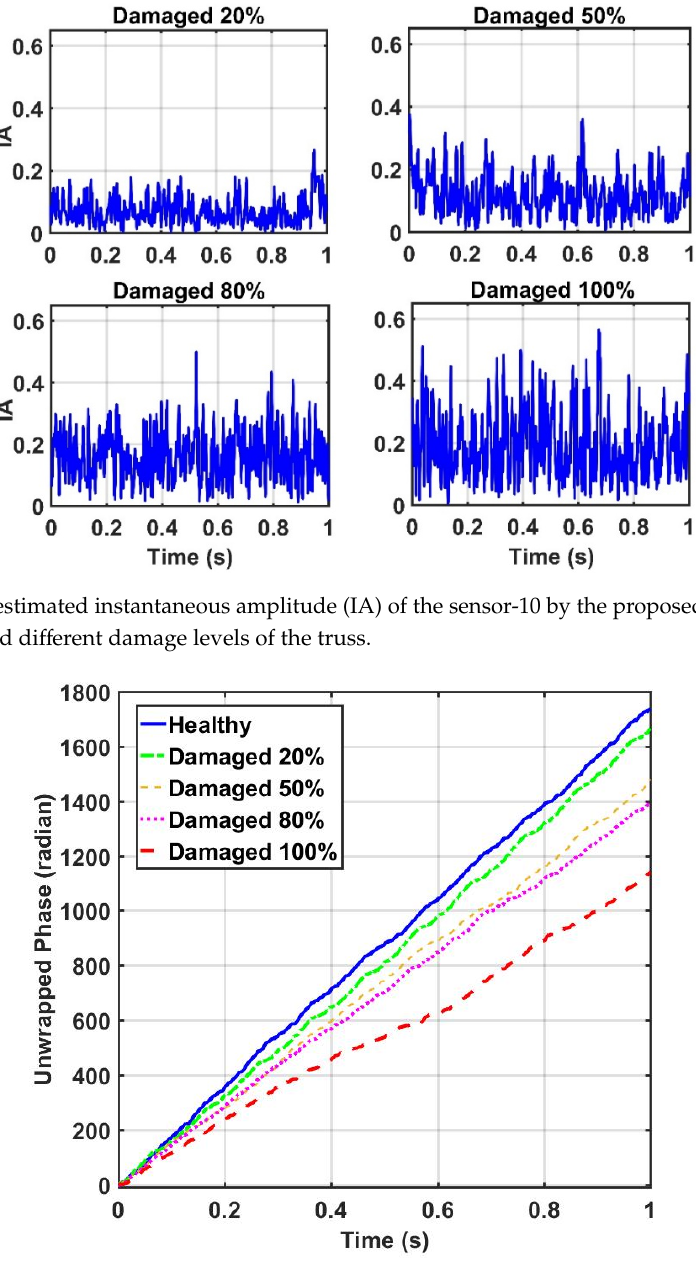
Figure 11. Comparison of the IMFs’ unwrapped phase of acceleration responses of sensor-10 estimated by the proposed model for the healthy and different damage levels the truss.